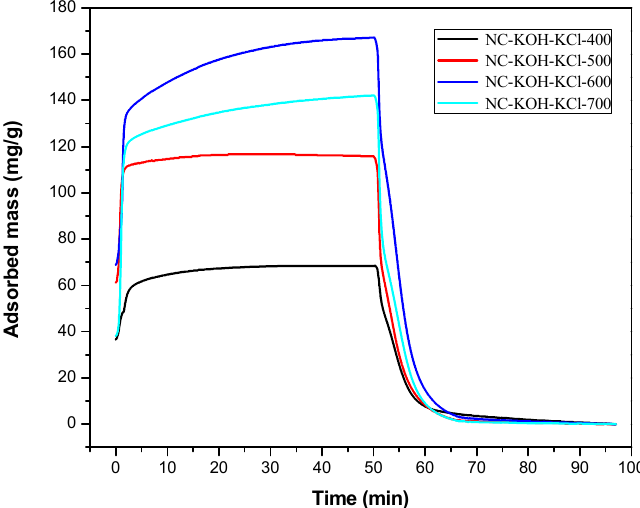
Figure 2. TG curves measured CO 2 adsorption and desorption of samples carbonized at different temperatures.